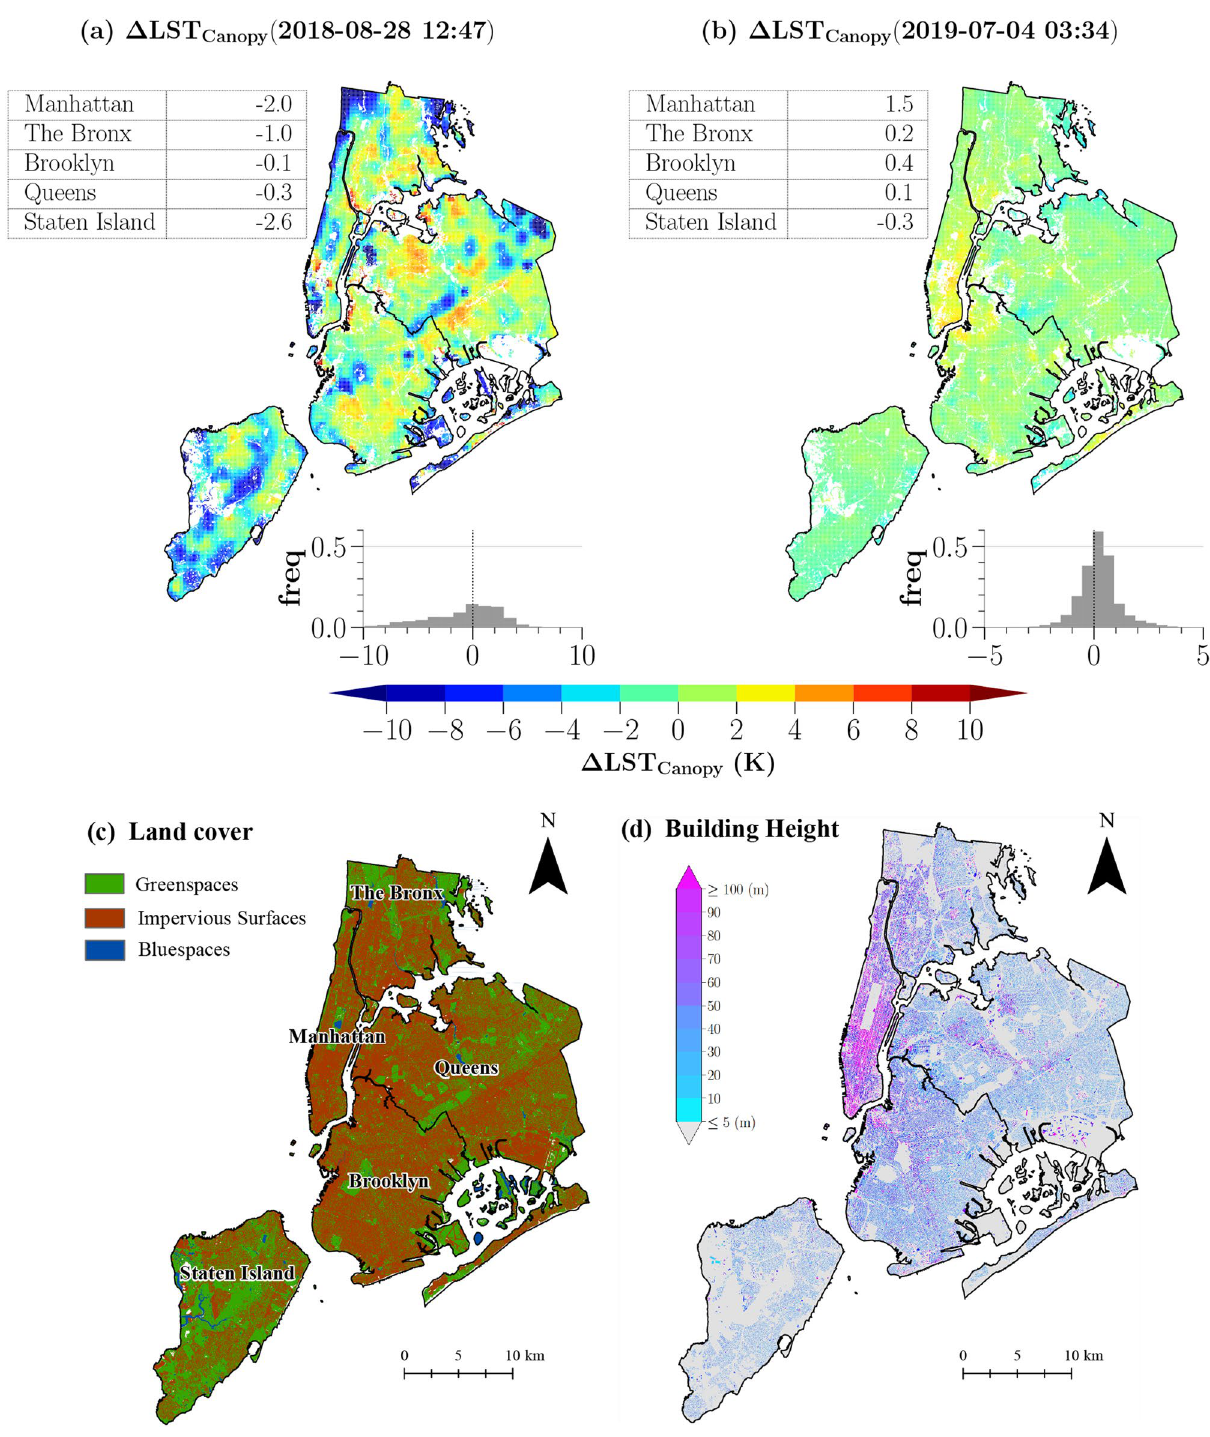
Figure 2. Spatial anomalies of canopy temperature ( (cid:31) LST Canopy ) for day ( a ) and night ( b ). The histograms show the distribution of (cid:31) LST Canopy . Borough mean of (cid:31) LST Canopy are shown in the table (K). Summary of urban land covers ( c ) and building height distribution ( d ) of NYC. Maps created in Python 3, using the canopy temperature dataset generated based on the downscaled approach (a and b) and in ArcGIS 10, using NYC Land Cover 2017 42 and Building vector dataset 43 ( c , d ) (links are provided in the “Data availability”